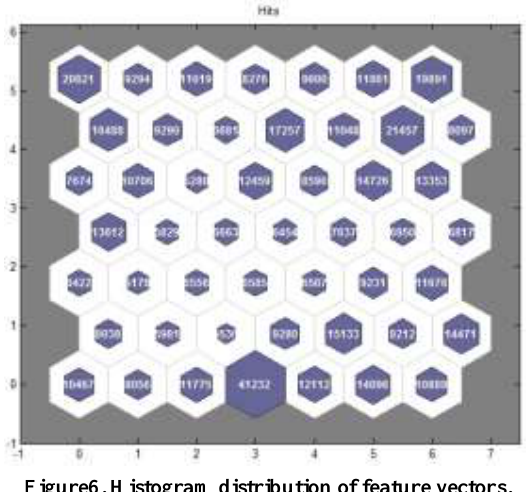
Figure6. Histogram distribution of feature